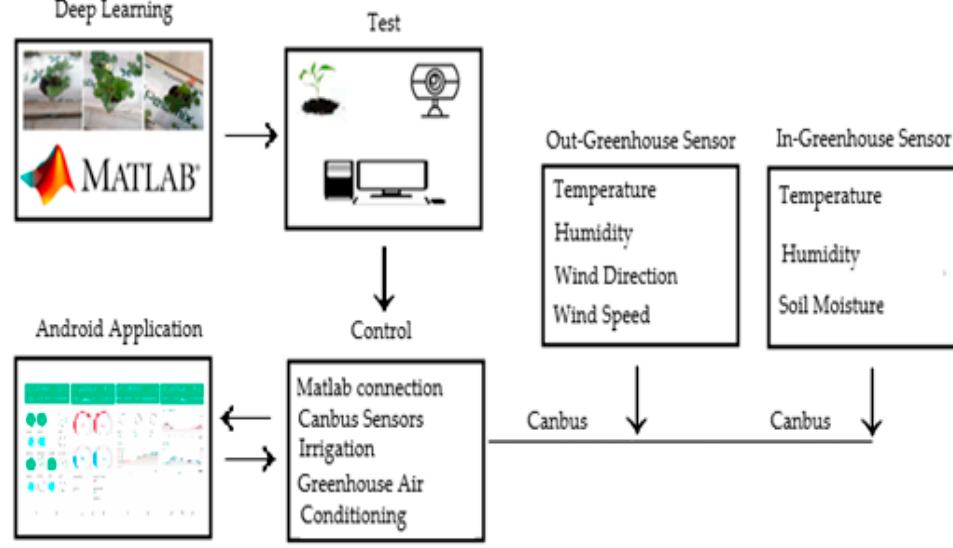
Figure 1. General structure of the system.